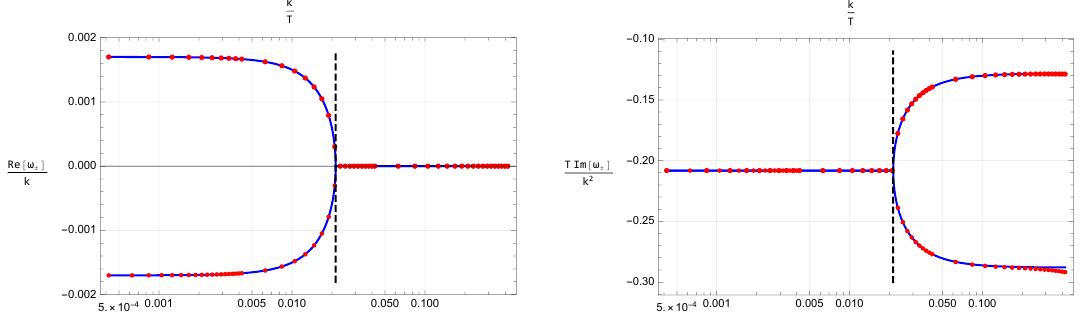
Figure 4 . Plots of Reω ± the numerical results and the solid lines are the analytic predictions. The dashed lines are at k = 0 . 0212842 T